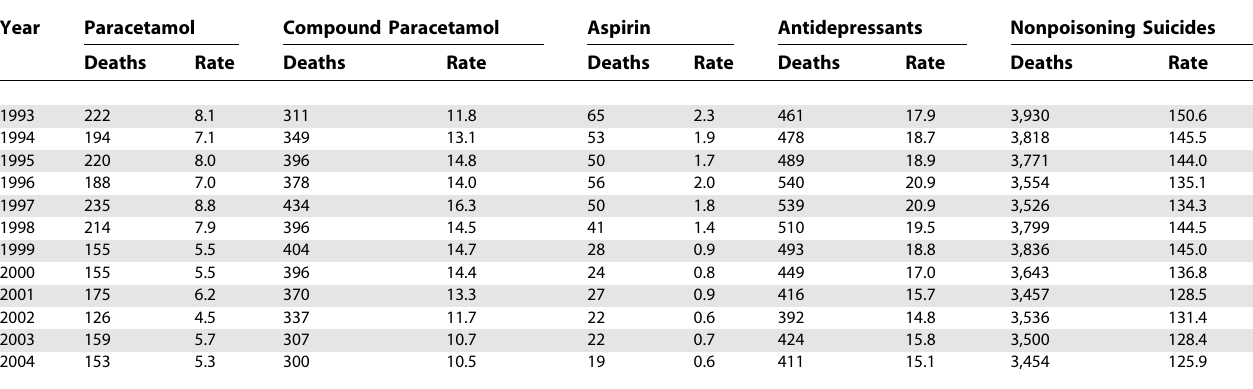
Table 1. Number of Deaths and Age-Standardised Mortality Rate per Million for Poisoning Involving Paracetamol, Paracetamol Compounds, Antidepressants, and Nondrug Poisoning Suicide, England and